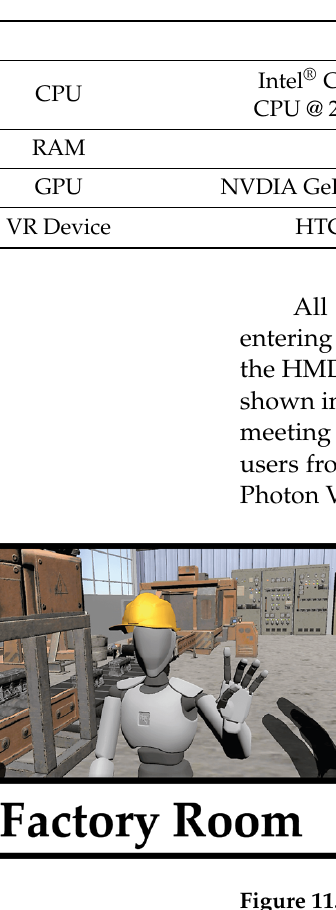
Table 4. Experiment environment.